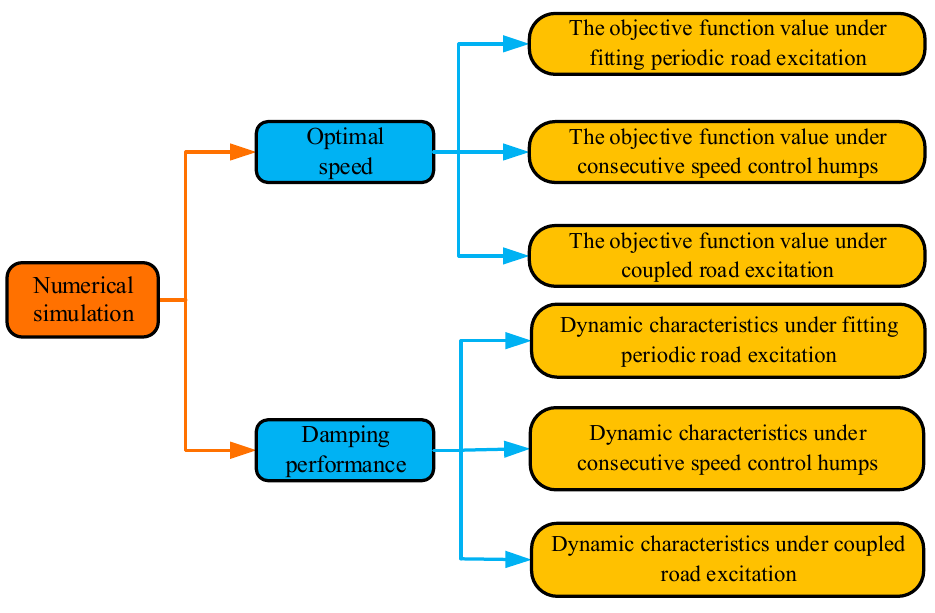
Figure 6. Simulation condition schematic.